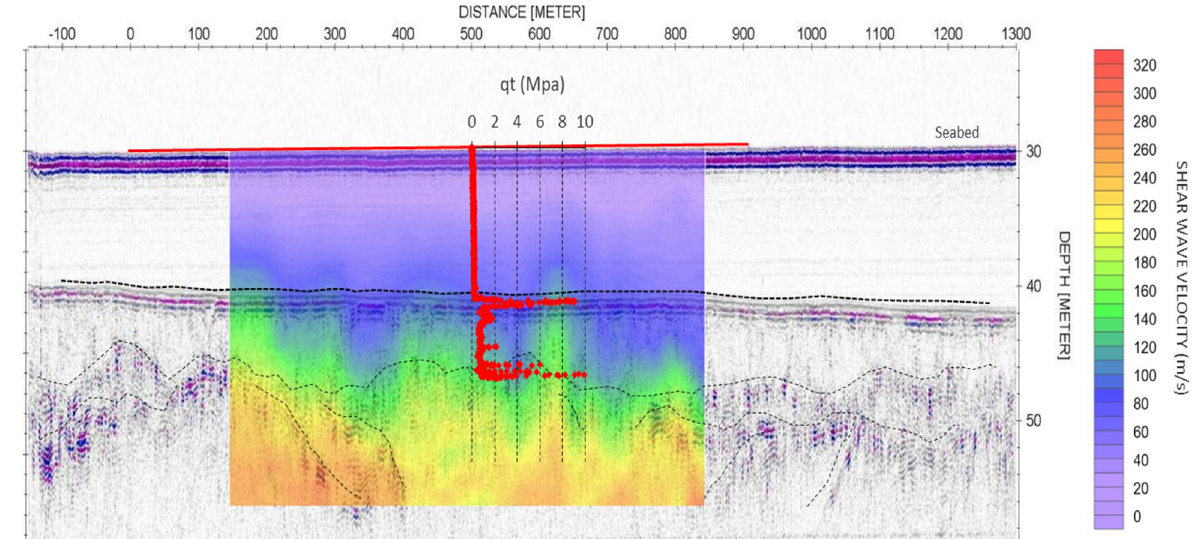
Figure 6. 2D Shear Wave velocity profile (colour scale image) and CPT cone resistance, q t (red line graph) overlaid on high resolution sparker reflection data (pseudo grey scale image) from Site